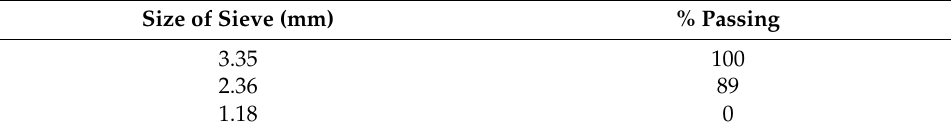
Table 2. WPET gradation